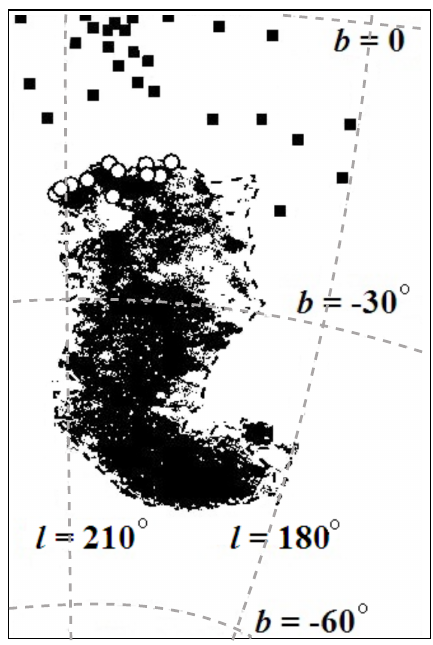
Fig. 3. Open clusters in the area of the Eridanus Superbubble region in galactic coordinates according to Heiles et al. (1999). The open circles represent the open clus- ters associated with the Eridanus Superbubble, the squares denote other clusters in the selected area. galactic plane is located at a distance of (cid:24) 100 pc from the plane, while the